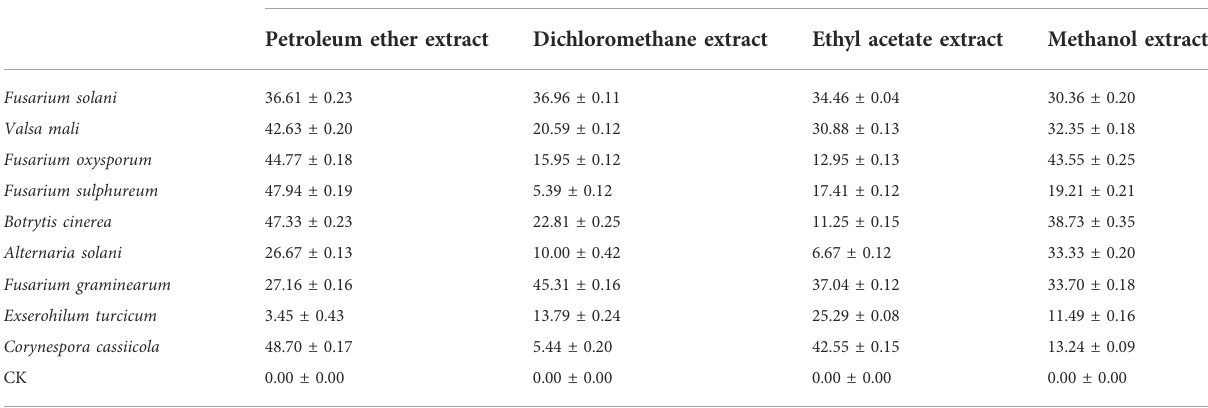
TABLE 1 Toxicity test results of extracts of A. mongolicum against nine plant-pathogenic fungi at a concentration of 0.5 mg/ml (96 h of incubation). Plant-pathogenic